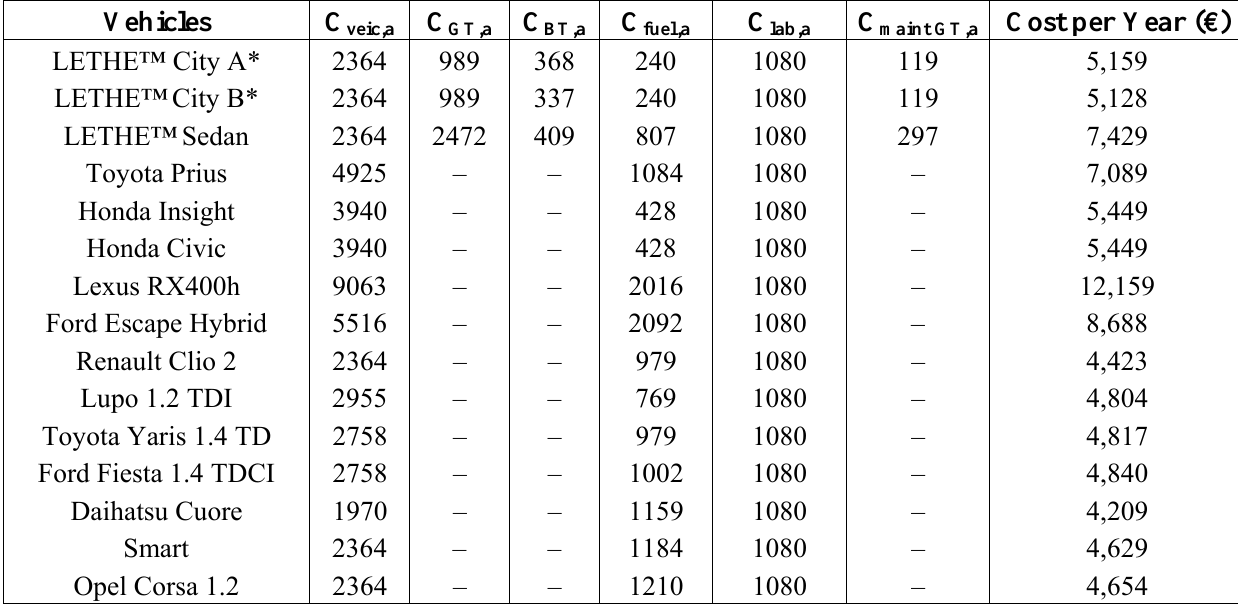
Table 14. Discounted costs at